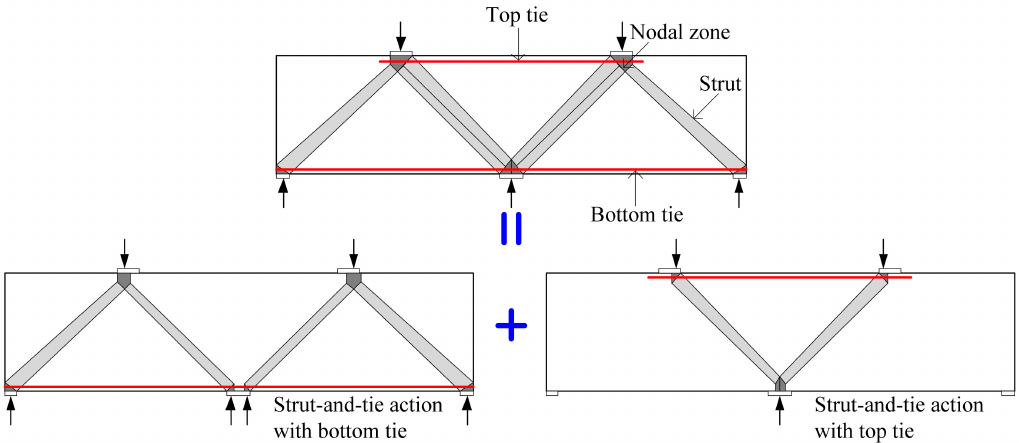
Figure 2. Combination of strut-and-tie actions with bottom and top ties in CDBs (adapted from Rogowsky [29]).